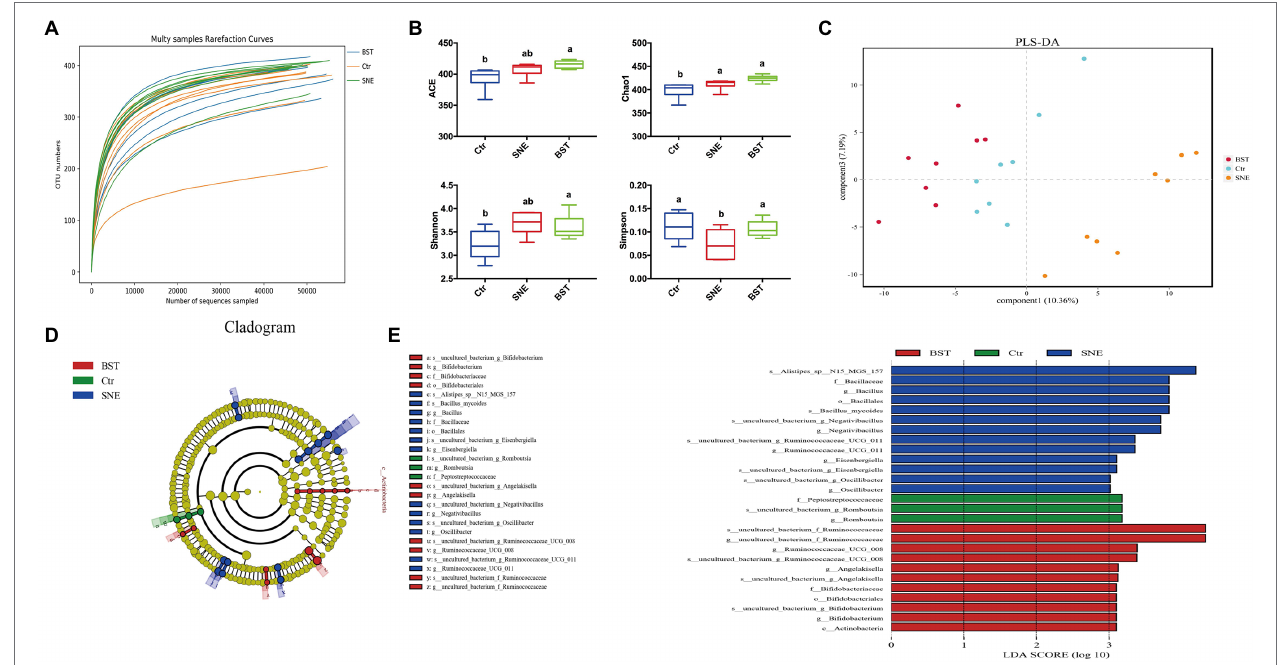
FIGURE 5 | The caecal bacterial community of broilers fed with dietary Bacillus subtilis DSM 29784 supplementation among Ctr, SNE and BST treatments. (A) Rarefaction curve for total OTUs; (B) α -Diversity of gut microbial was analyzed among Ctr, SNE, and BST treatments by determination of principal dimension ACE, chao1, Shannon, and Simpson indices; (C) Partial Least Squares Discriminant Analysis of gut microbiota at the operational taxonomic unit (OTU) level; (D) Cladogram; and (E) LDA value distribution histogram. Bacterial taxa significantly differentiated among Ctr, SNE, and BST treatments identified by linear discriminant analysis coupled with effect size (LEfSe) using the default parameters. Bacterial taxa with LDA score > 3 are selected as biomarker taxa (p: phylum level; c: class level; o: order level; f: family level; g: genus level). Ctr group, basal diet in control group; SNE group, basal diet + SNE (20-fold dose coccidiosis vaccine) +1 ml of Clostridium perfringens (2 × 10 8 cfu/ml coinfection); BST group, basal diet (days 1–21) + 1 × 10 9 colony-forming units (cfu)/kg BS diet (days 22–63) +